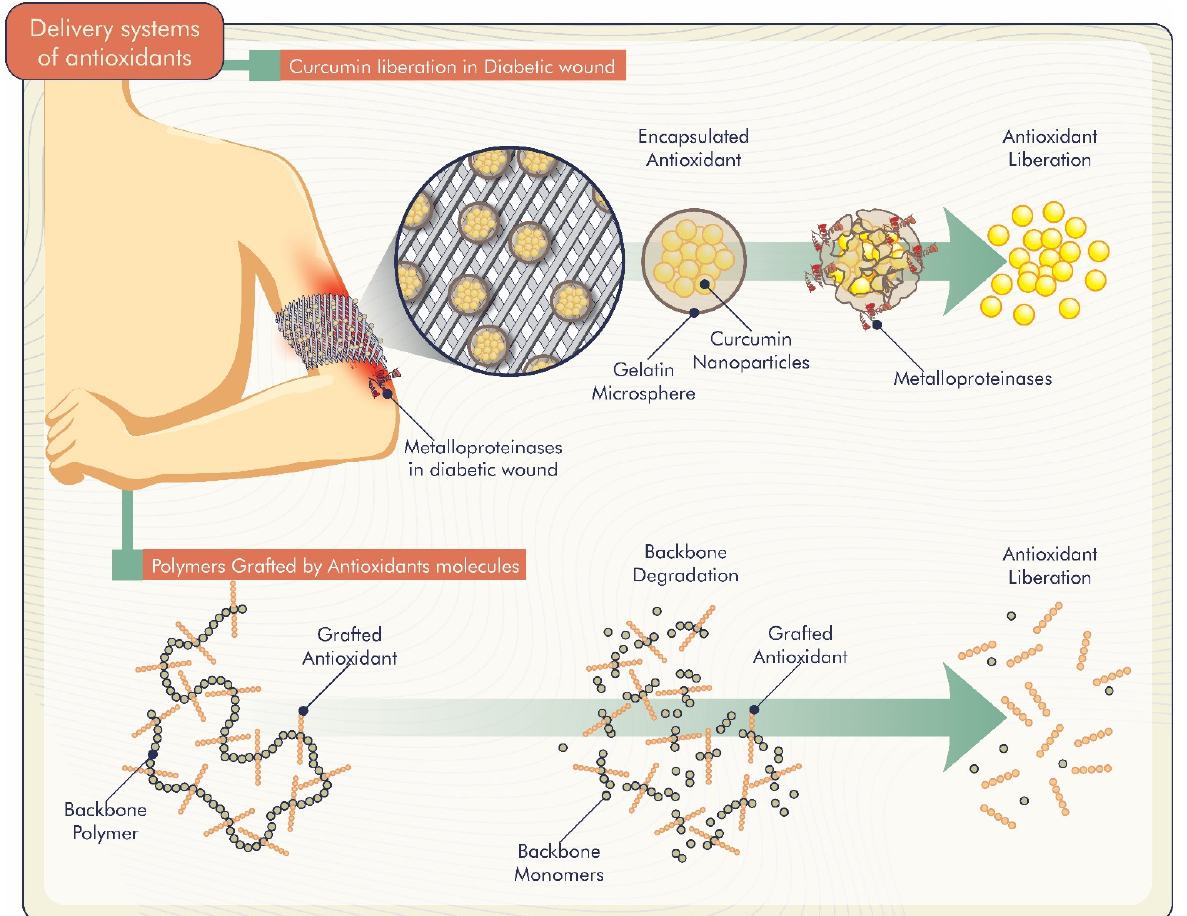
Figure 4. Controlled release mechanisms of antioxidants incorporated into biomaterials.